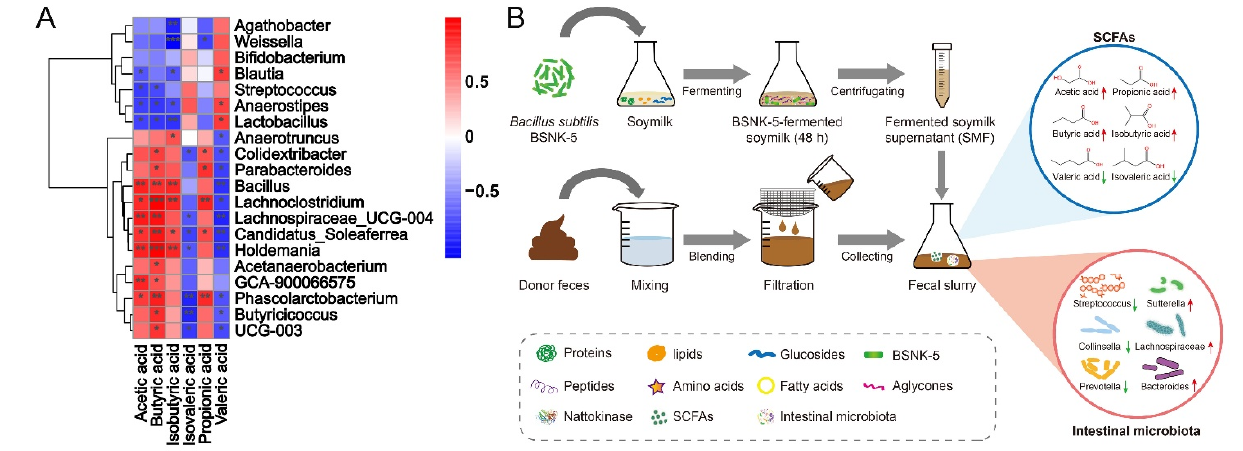
Figure 5. The correlation heatmaps ( A ) and overview ( B ) of gut microbiota and SCFAs. The signifi- cantly different results were indicated by specific symbols (*, p < 0.05; **, p < 0.01; ***, p < 0.001).